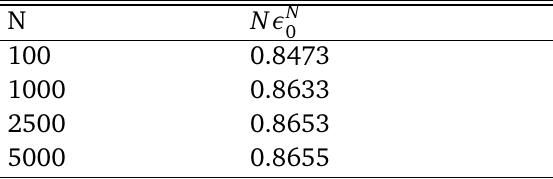
Table 3. N ε N for increasing N ( J = 1, B = 1 / 0